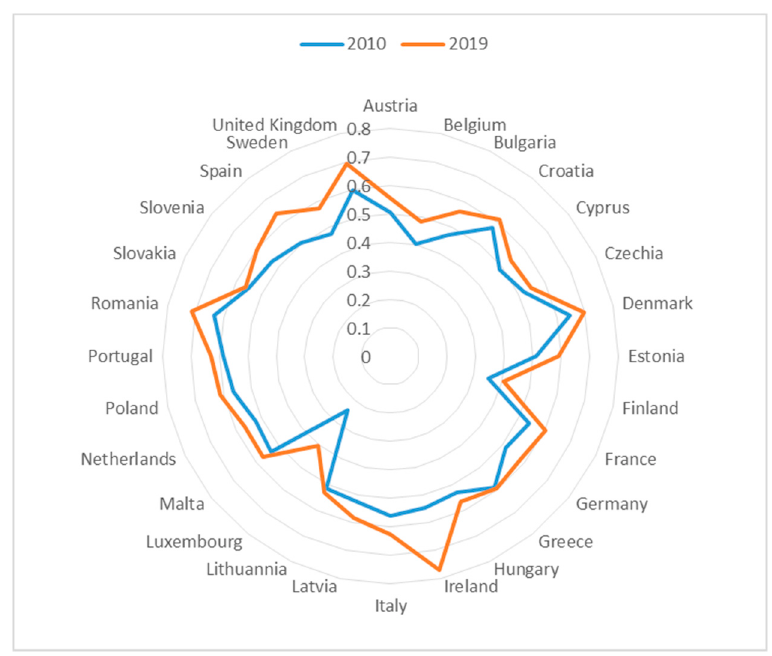
Figure 4. The average level of fulfilment of headline target 2 of Europa 2020 Strategy (Increasing energy efficiency by 20%) in case of the EU28 in the years 2010 and 2019.